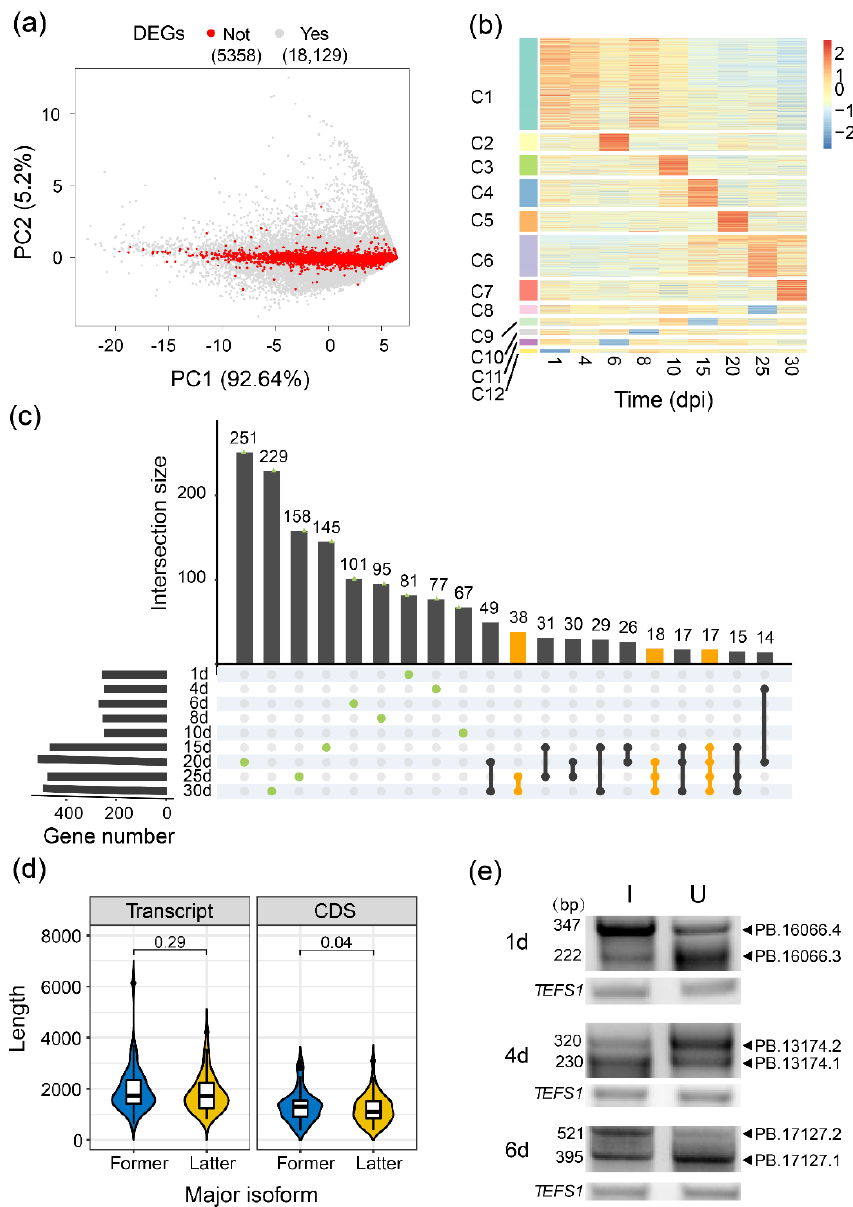
Figure 3. Global differential transcript usage analysis on isoform level. ( a ) PCA analysis of all expressed genes. Red points showed the not differentially expressed genes (nDEGs), grey points showed the differentially expressed genes (DEGs); ( b ) Expression patterns of differentially expressed transcripts (DETs) from nDEGs. The values were calculated by (FPKM Inoculation + 1)/(FPKM Uninoculation + 1) and scaled using Z-score; ( c ) Intersections of various gene sets experienced major isoform switches between inoculated and uninoculated conditions during nodule development, including stage-specific (green dots) and continuous changes (yellow lines); ( d ) Comparison of transcript and CDS lengths between the former and latter isoforms, where major isoform switched irreversibly and characteristically under inoculation; ( e ) RT-PCR validation of expression levels DETs from ( b ).